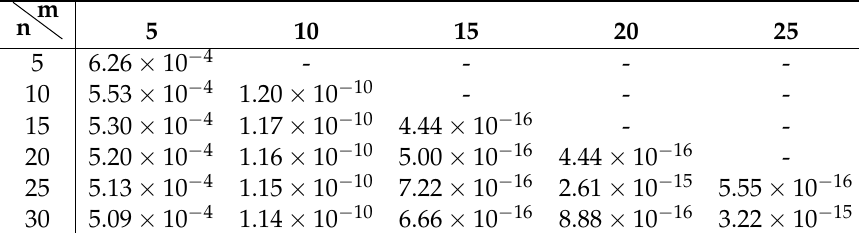
Table 2. Maximum test set solution error using Chebyshev polynomials for Problem # 1.